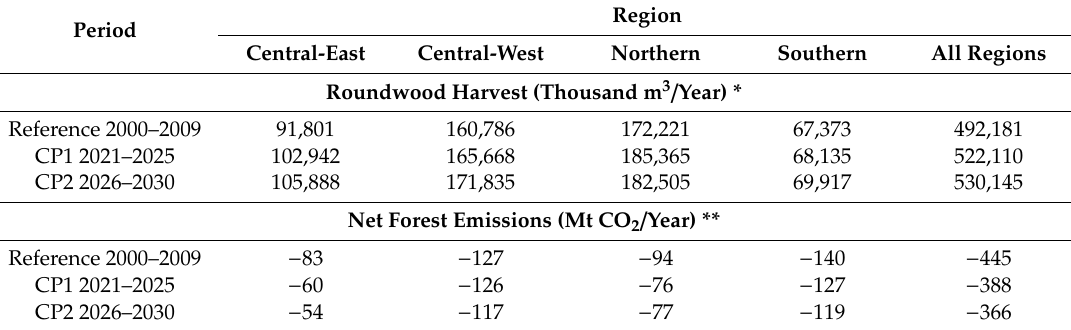
Table 4. Annual harvest of roundwood and net forest emissions for the BAU-only scenario across the di ff erent regions.